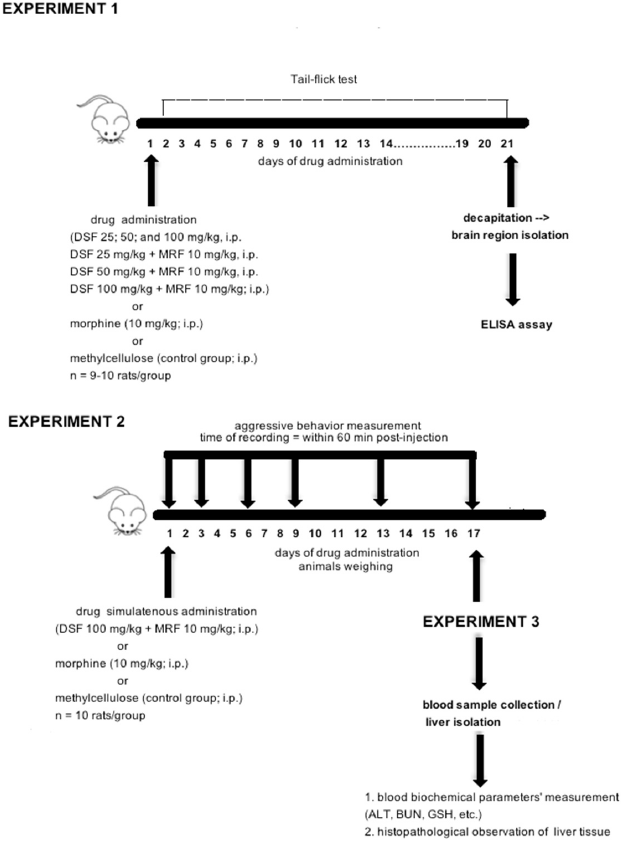
Figure 1. Timeline and schematic presentation of the in vivo experiments.